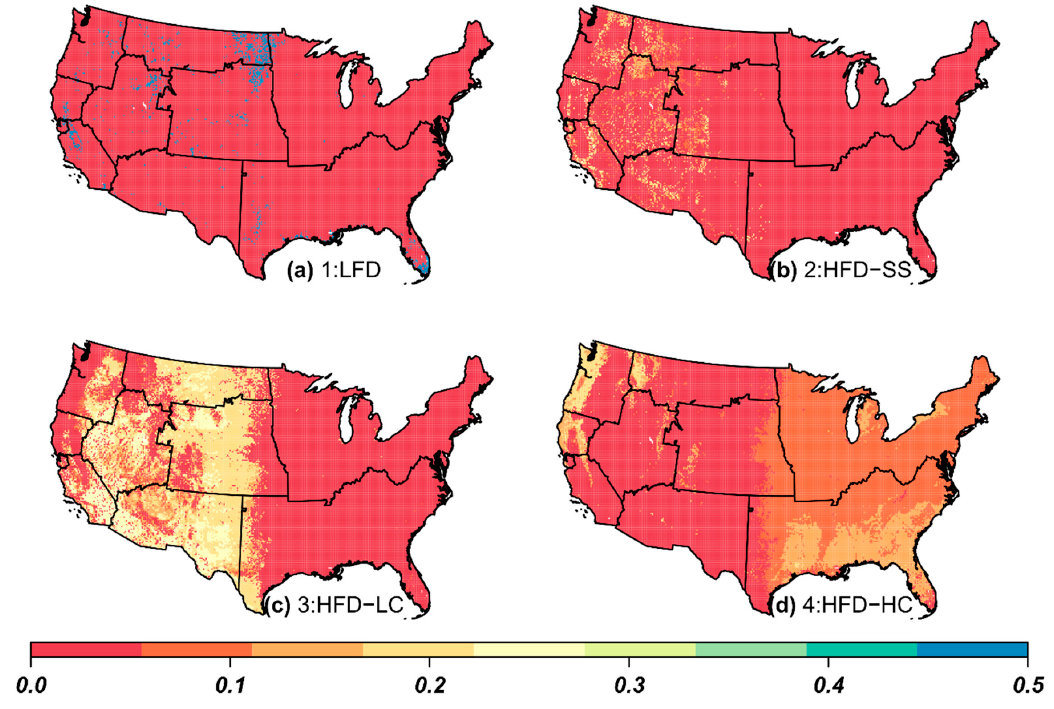
Figure 11. Proportion of days between 1981 and 2017 that were classified as having environmental conditions similar to firefighter entrapments within cluster 1 (LFD) ( a ), cluster 2 (HFD-SS) ( b ), cluster 3 (HFD-LC) ( c ), and cluster 4 (HFD-HC) ( d ).